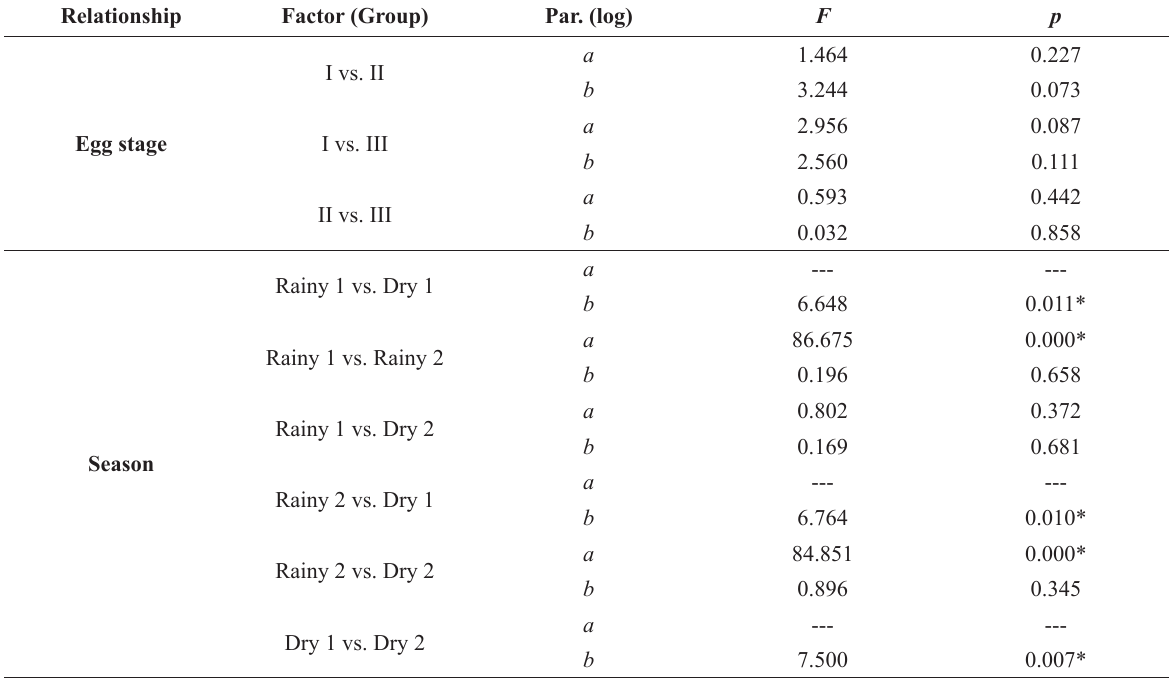
Results of the Covariance analysis (ANCOVA) of the relationship between female size (CL) and fecundity for